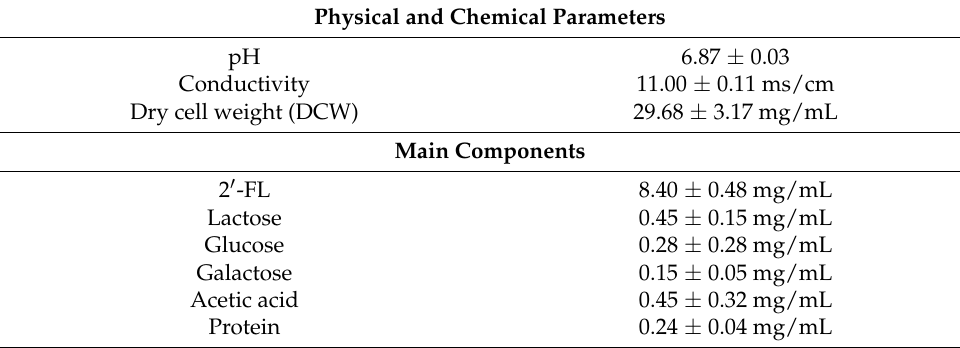
Table 2. Initial Parameters of Fermentation